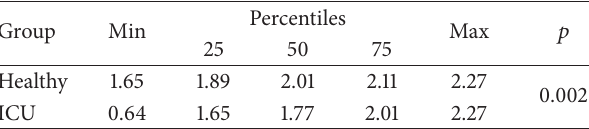
∗ Min: the minimum area of serum diffusion, Max: the maximum area of serum